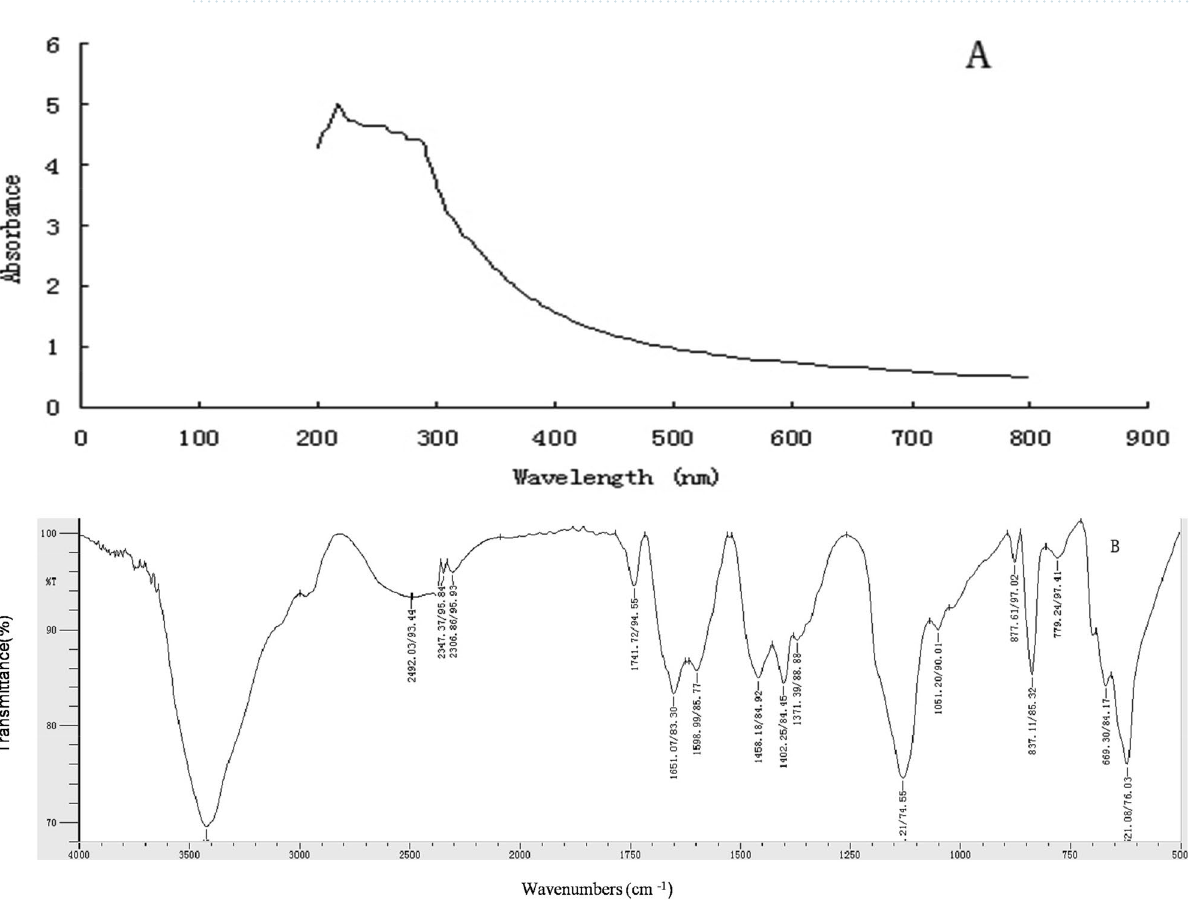
Figure 3. UV–vis and FTIR spectra of the EPS from Bacillus subtilis